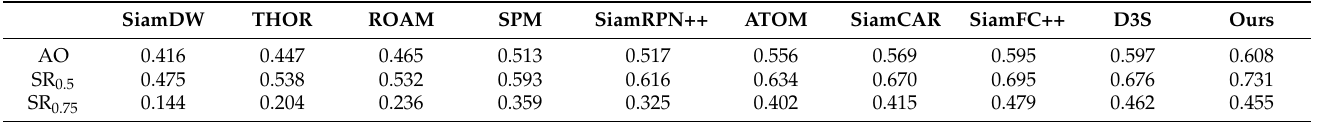
Table 3. Performance comparisons on the GOT-10k